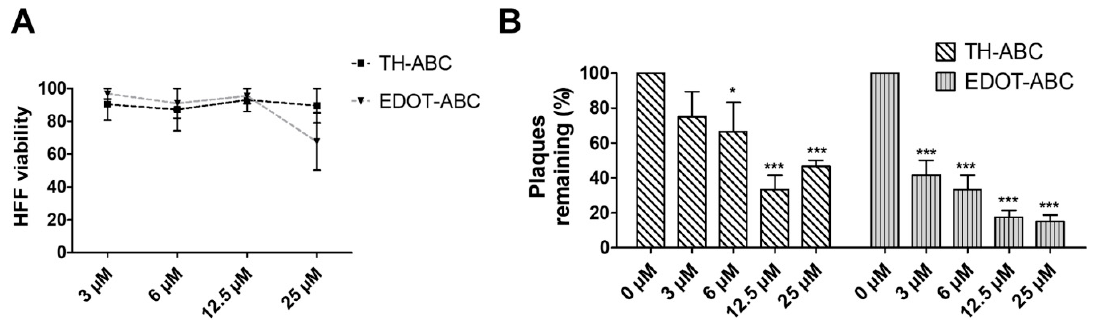
Figure 2. SL derivatives antiviral activity against HCMV. ( A ) Viability was measured using the MTT assay. Confluent HFF cultures were seeded in 96-well plates and incubated with different concentrations of SLs for 144 h. Graphs are representative of three independent experiments with duplicate replicate wells for each analysis. ( B ) Antiviral activity of TH-ABC and EDOT-ABC on HCMV replication. HFF cells were pre-treated with the indicated dilutions of SLs for 2 h. Subsequently, the HFFs were infected with the HCMV Merlin strain (MOI of 0.1) and, following virus adsorption (2 h at 37 °C), the viral inoculum was removed and the cultures were exposed to increasing dilutions of either the SLs or vehicle (DMSO) and incubated for 144 h. Supernatants and cell-associated viruses—obtained from freeze (liquid nitrogen)/thaw (37 °C) cycles—were combined, and virus infectivity titers were determined by plaque assay. Plaques were microscopically counted, and the mean plaque counts for each compound concentration were expressed as a percentage of the mean count of the control (*, p < 0.05; ***, p < 0.001, two-way ANOVA followed by Bonferroni’s post-tests).